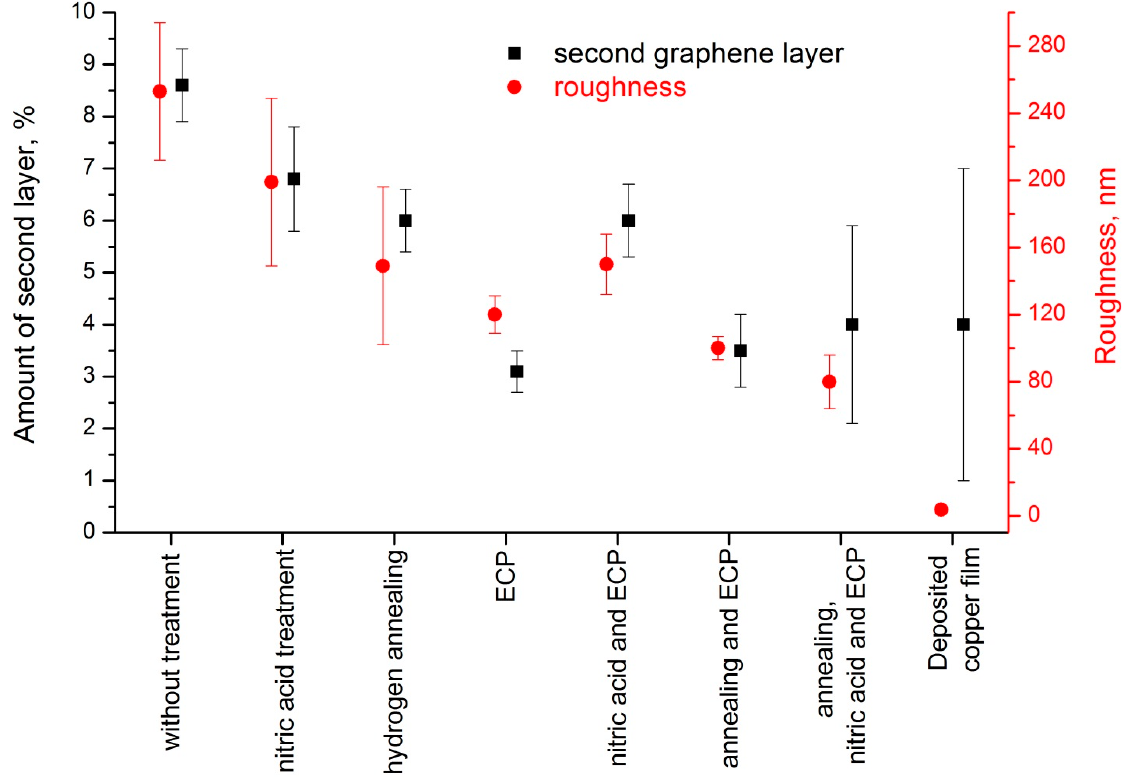
Figure 6. The effect of method of copper treatment on average roughness of copper surface (red circles) and the amount of graphene additional layer (black squares).